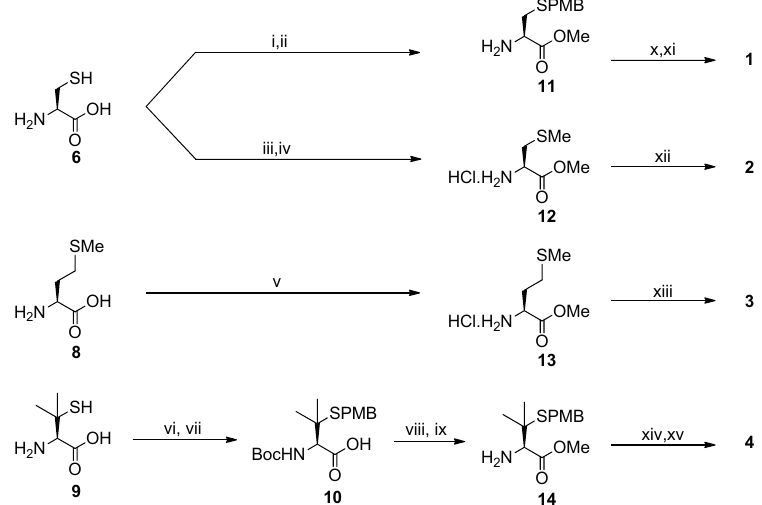
Scheme 1. Synthesis of ligands 1 – 4 from pyridine-2,6-dicarboxylic acid ( 5 ) and the amino acids L -cysteine ( 6 ), L - S -methylcysteine ( 7 ), L -methionine ( 8 ) and L -penicillamine ( 9 ).